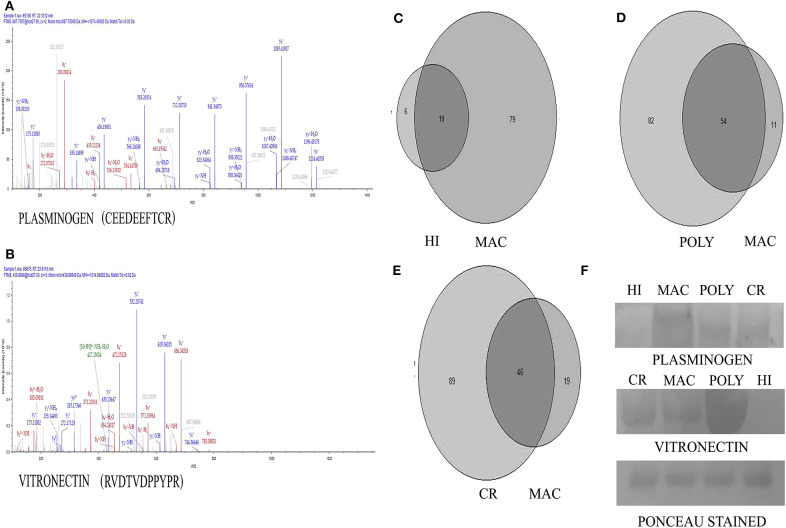
Representative MS-MS spectra of significantly altered proteins obtained from Q-ExactivePlus Orbitrap mass spectrometer study. (A) MS-MS spectra of Plasminogen (PLG) protein. (B) MS-MS spectra of Vitronectin (VTN) protein. (C) Venn diagram showing number of common proteins in all the patients with MAC lesions compared to HI. (D) Venn diagram showing number of common proteins in all the patients with MAC lesions compared to POLY lesions. (E) Venn diagram showing number of common proteins in all the patients with MAC lesions compared to CR individuals. (F) Validation of Plasminogen and Vitronectin using western blotting image Ponceau stained image of the blot after transfer.